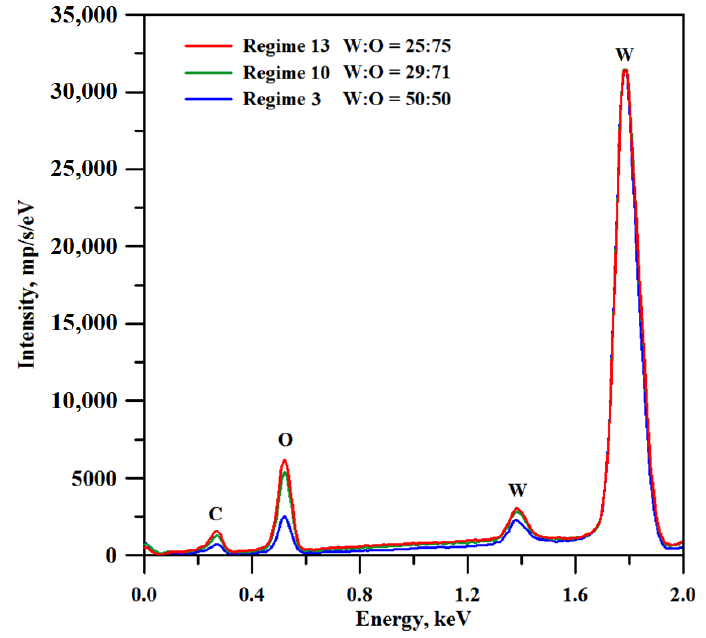
Figure 3. EDS spectra of tungsten samples textured with different laser treatment regimes. Note that the spectra were recorded for the samples prior to hydrophobization.